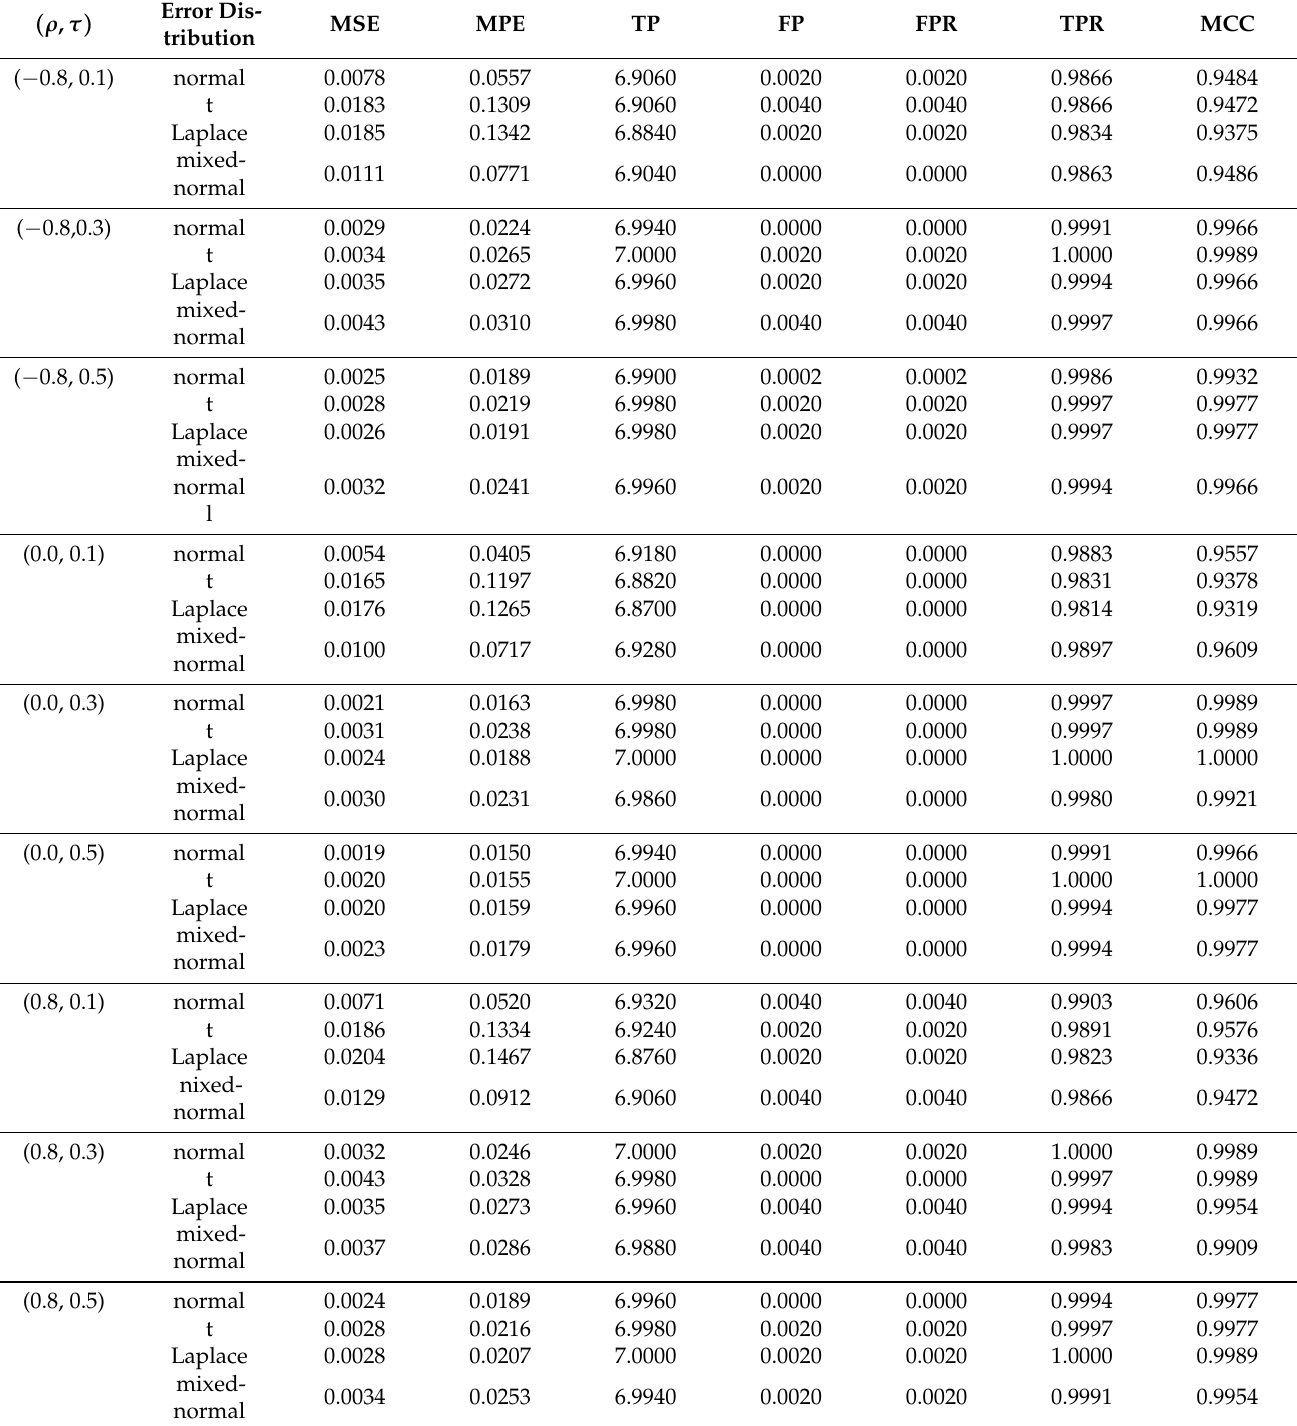
Table 3. Numerical results in the simulation study under Scenario